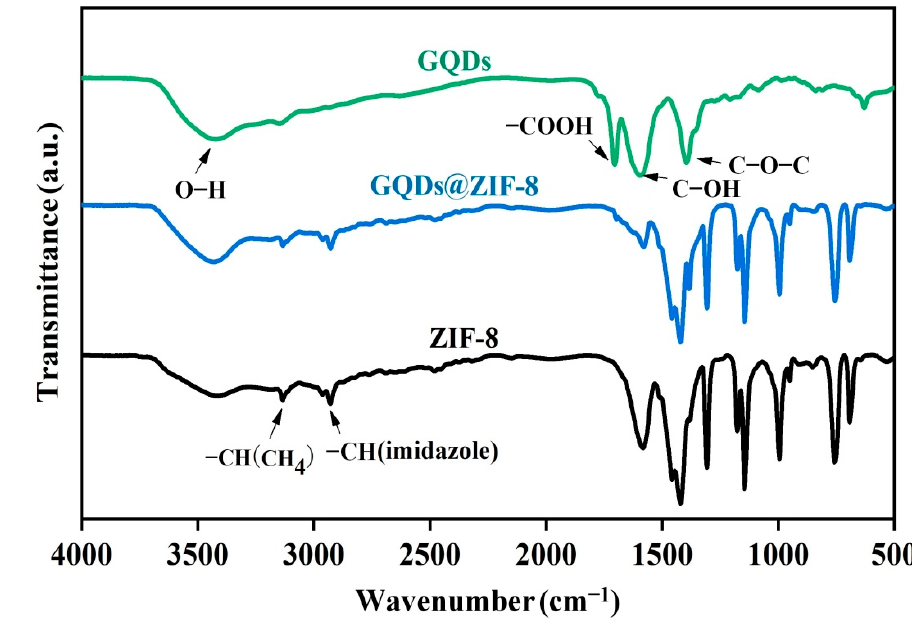
Figure 4. FT-IR spectra of GQDs, ZIF-8 and the GQDs@ZIF-8